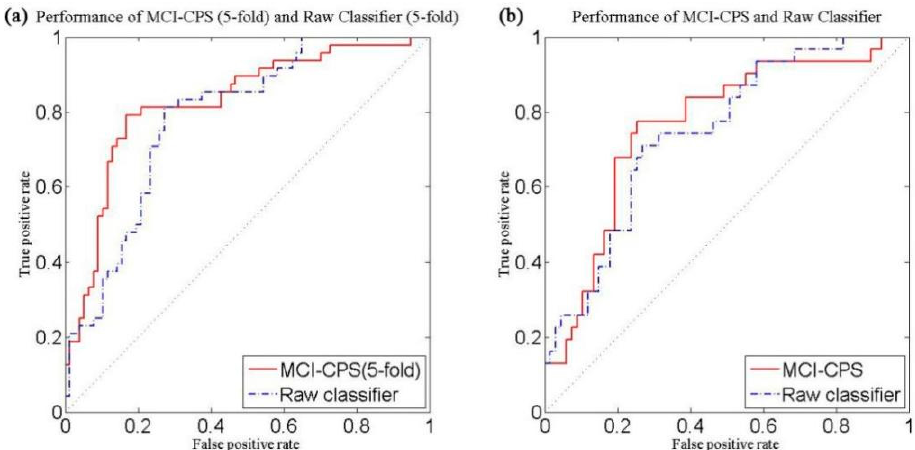
Figure 2. Performance curves for predicting conversion from MCI to AD, comparing MCI-CPS and Raw classifier. ( a ) Five -fold cross-validation in ADNI-1. Solid red line: MCI-CPS (5-fold), AUC = 0.8260; dashed blue line: Raw classifier (5-fold), AUC = 0.7849. ( b ) Performance of model with ADNI-GO/2 as an independent test set. Solid red line: MCI-CPS, AUC = 0.7809; dashed blue line: Raw classifier, AUC = 0.7646.